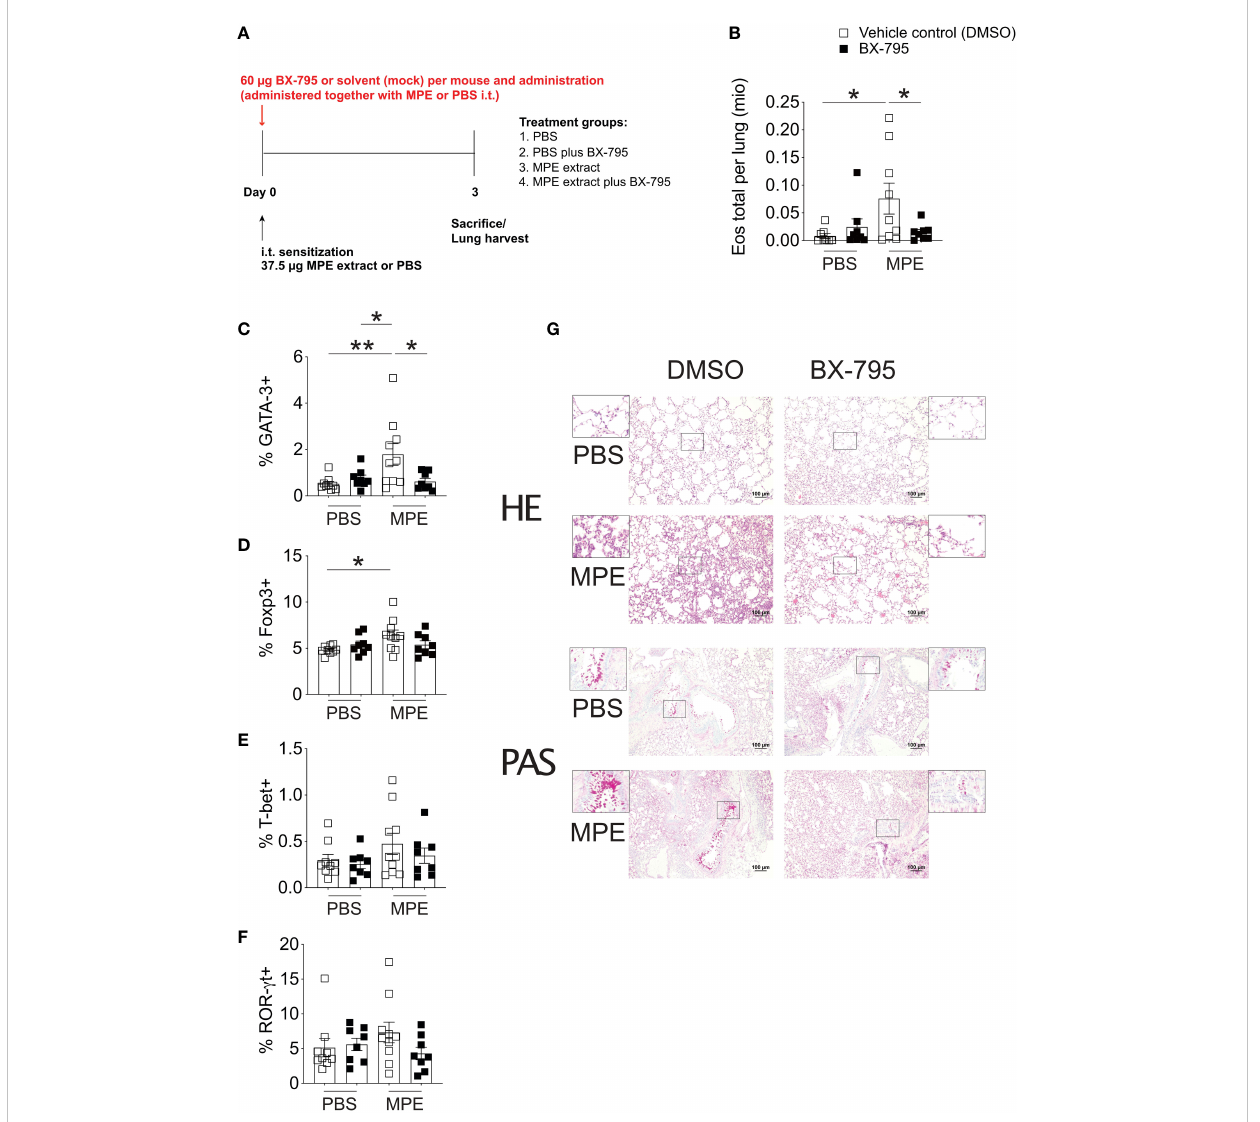
FIGURE 6 BX-795 ameliorates Th2 in fl ammation in a murine model of mugwort allergy. (A) , shown is the treatment protocol indicating the time points and dosage of mugwort-pollen extract (MPE) or sham treatment (PBS) and concomitant BX-795 exposure of mugwort-speci fi c TCR/DR1 double transgenic C57BL/6 mice. All conditions contained the same amounts of solvent (DMSO). (B) , shown are the absolute numbers of eosinophils expressed as 1x10 6 cells per lung of mice treated as in (A) determined by FACS analyses (gating strategy see Figure S15) of lung homogenates. (C-F) , shown are the percentages of GATA-3 + , Foxp3 + , T- bet + and ROR- g t + of CD3 + CD4 + T cells in the lung of mice sensitized by i.t. administration of MPE or placebo (PBS) in the presence or absence of i.t. applied BX-795 as determined by FACS analyses. (G) , shown are representative lung sections stained with hematoxylin eosin (HE, upper panel) or periodic acid-Schiff (PAS, lower panel) of mice of the indicated treatment groups. (B-F) , data show the mean ± SEM of pooled result from two independently performed experiments containing 8-10 mice in total per group. The indicated p-values were calculated using one-way ANOVA followed by Dunnett ’ s test comparing MPE stimulated BX-795 treated to counterparts. Only statistically signi fi cant changes are indicated with *, p < 0.05; **, p <